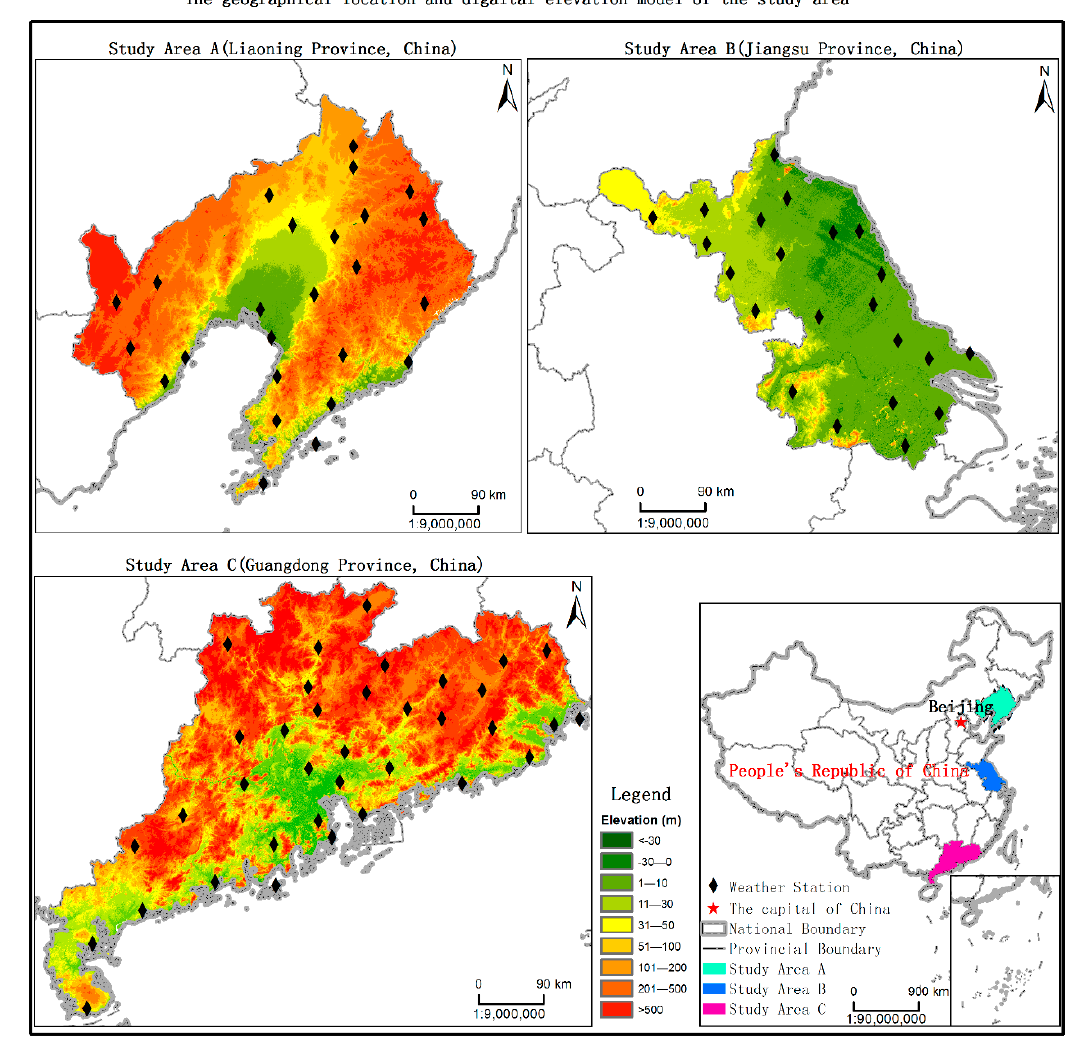
Figure 1. Schematic diagram of Guangdong, Jiangsu and Liaoning research areas.